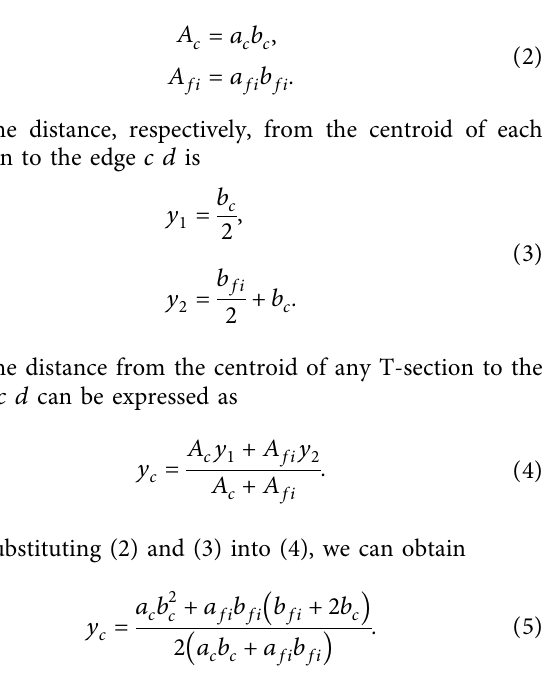
Figure 3: 1-1 sectional